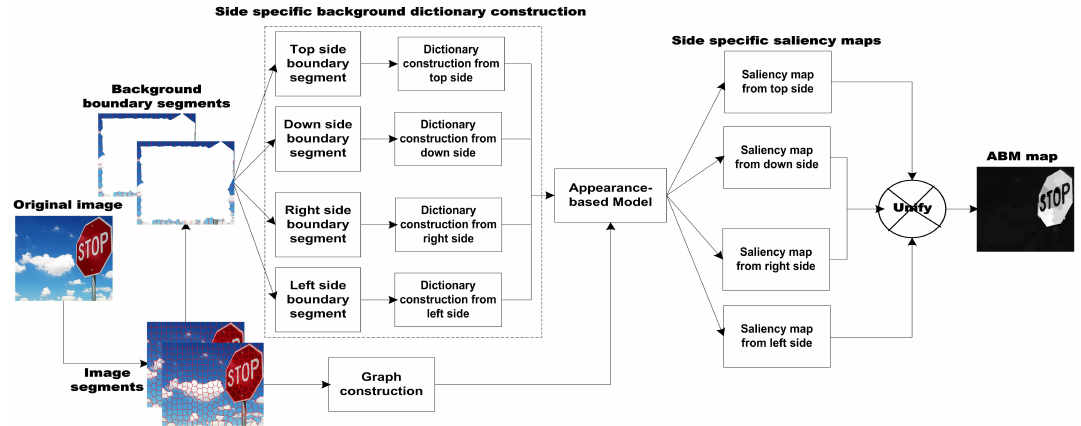
Figure 1. The pipeline of proposed salient region detection